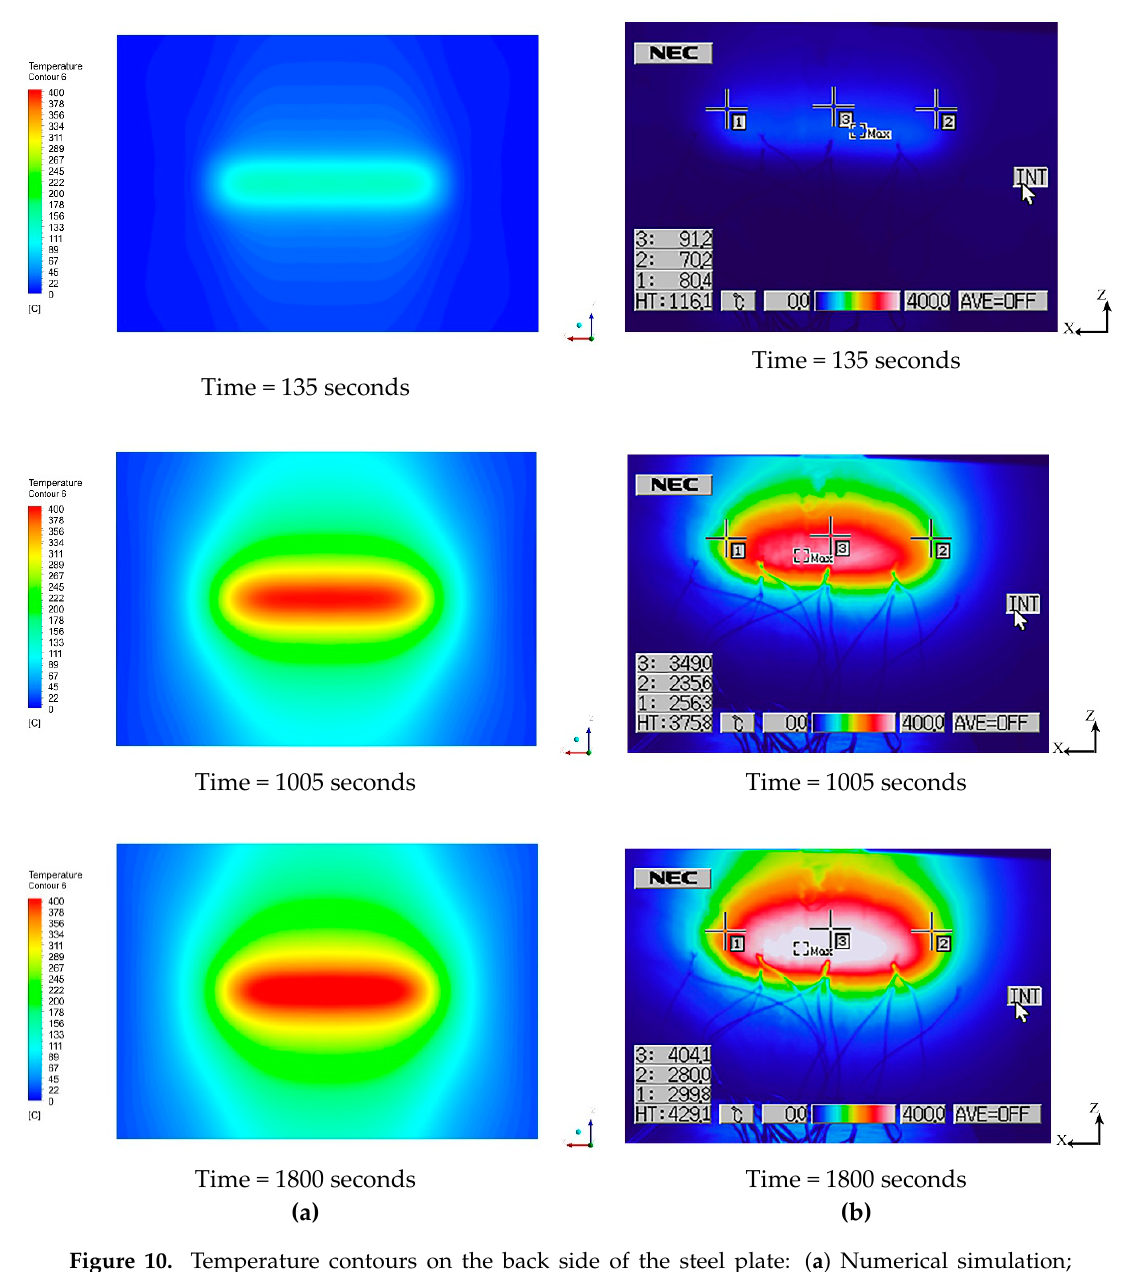
Figure 10. Temperature contours on the back side of the steel plate: ( a ) Numerical simulation; ( b ) experiment results.